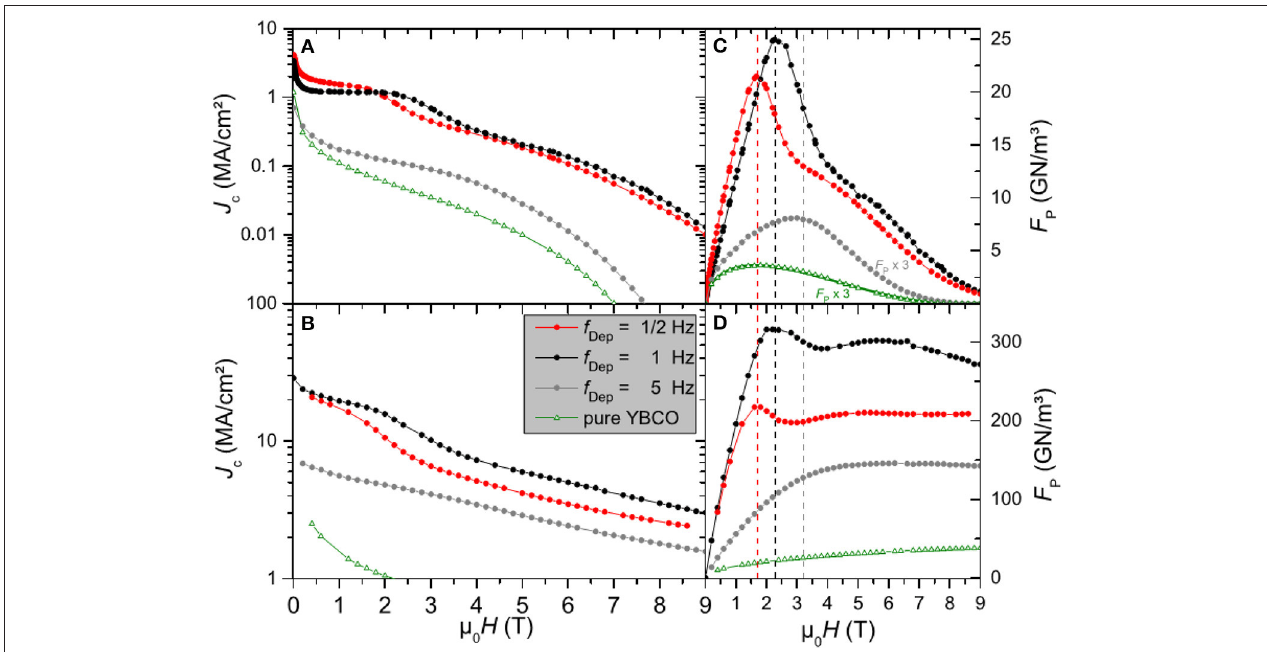
2.5 mol% YBNO 2.5 mol% YBTO) thin films, deposited at different + +